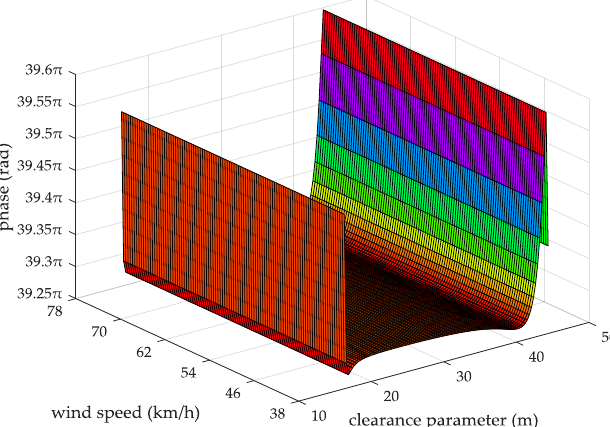
Figure 12. The ASFs of the AIS received signal changing with the wind speed and the clearance parameter.